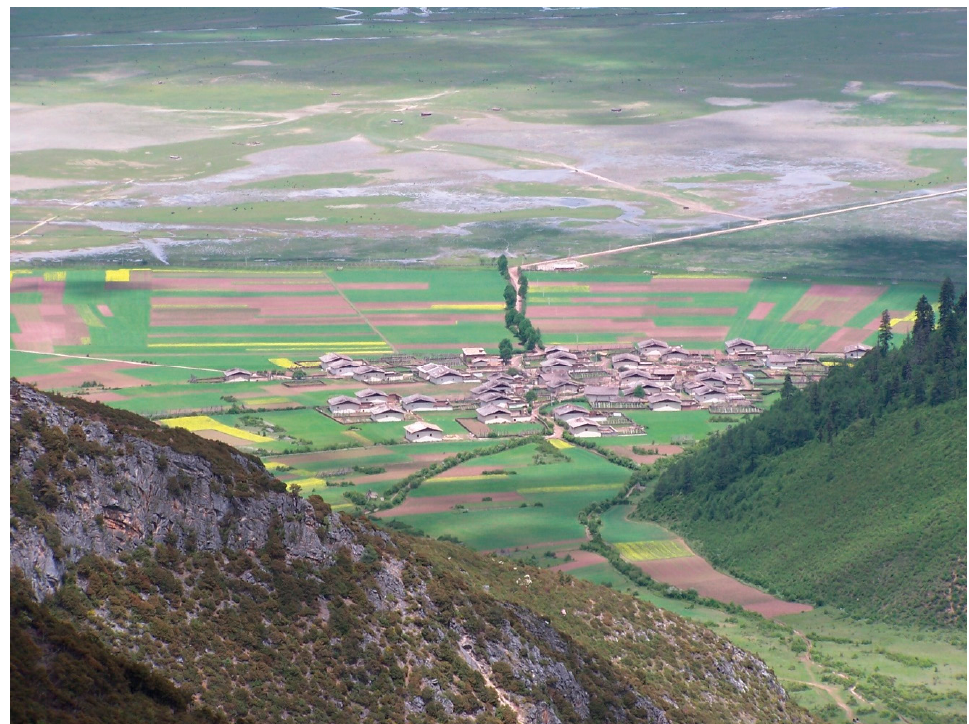
Figure 4. A view of Hamugu village from high in the Duji Sacred Gorge. Hamagu sits on the edge of Napahai, a wet prairie, where livestock are grazed. The Napahai Nature Reserve provides habitat for migratory waterfowl. Rising Sun Spirit Lake is a wetland lying within the prairie. (Photo by the author, 2006)